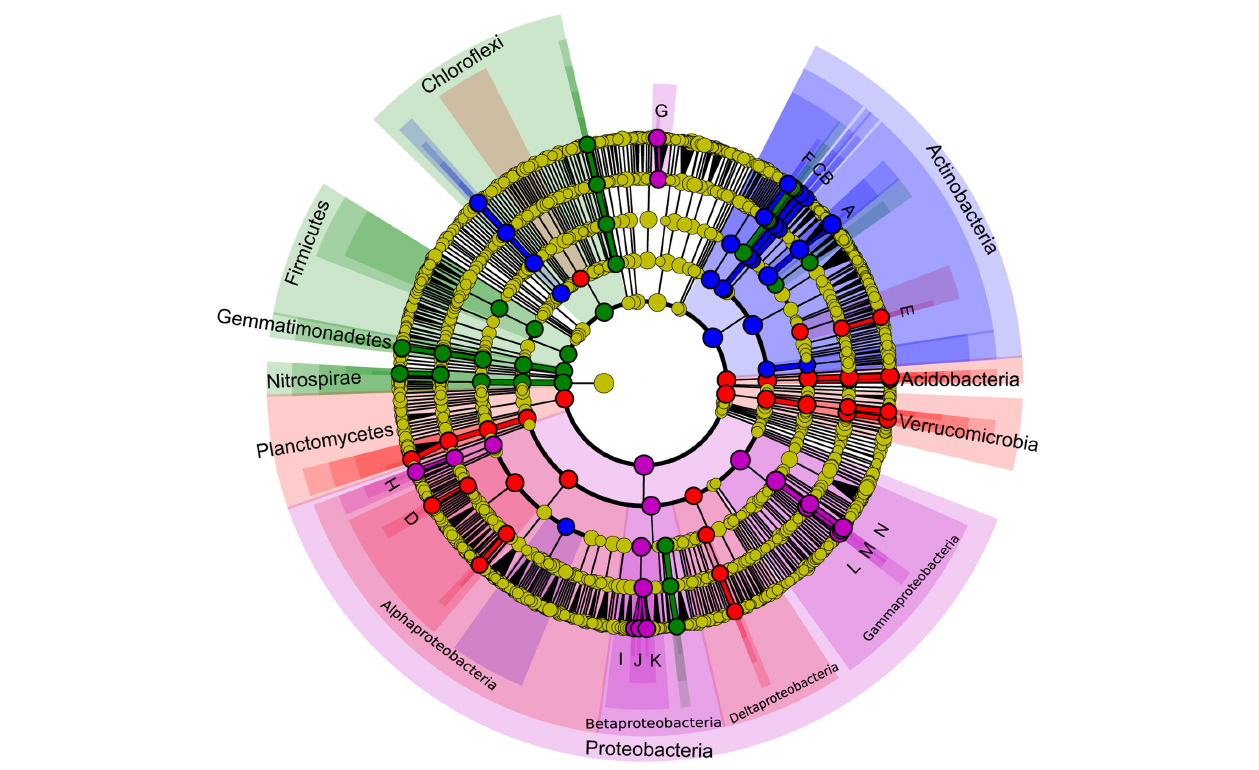
FIGURE 7 | Least discriminant analysis (LDA) effect size taxonomic cladogram comparing bacterial communities with a score higher than four. Nodes from inside to outside circles represent the bacterial taxon from phylum to genus level, respectively. Significant discriminant taxon to a specific habitat and its branch areas are highlighted with red, green, blue and pink, which correspond to overlying soils, sediments, weathered rocks and drip water, respectively. Yellow nodes represent taxa that do not significantly discriminate between habitats. The diameter of the node is positively correlated with the relative abundance of the taxon. Abbreviations of discriminant genus are indicated: A, Crossiella ; B, Euzebya ; C, Rubrobacter ; D, Bradyrhizobium ; E, Acidothermus ; F, Gaiella ; G, Sediminibacterium ; H, Brevundimonas ; I, Acidovorax ; J, Hydrogenophaga ; K, Polaromonas ; L, Acinetobacter ; M, Perlucidibaca ; N, Pseudomonas